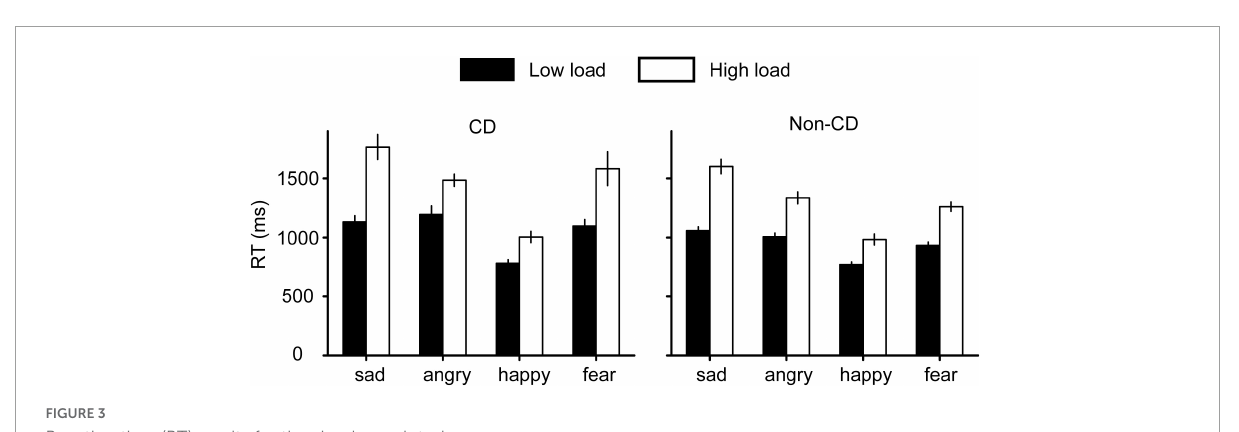
For search slopes ( Table 2 ), a 4 (emotion) × 2